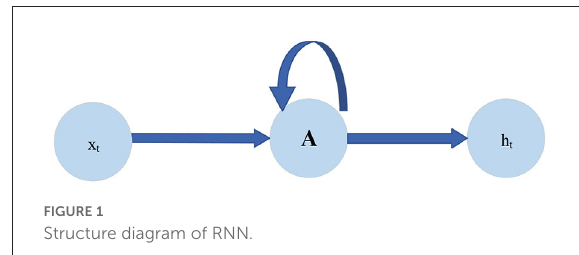
FIGURE1 Structure diagram of